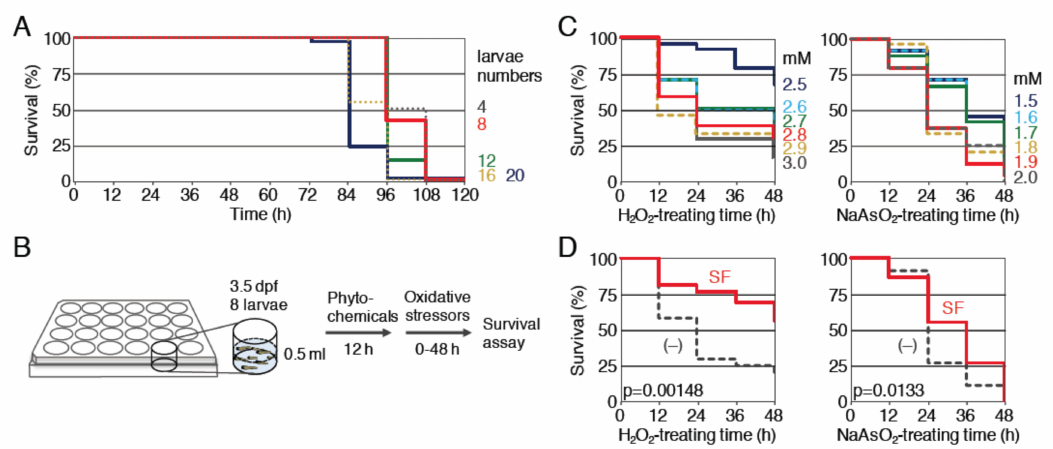
Figure 1. Survival assays of zebrafish larvae against oxidative stressors using 24-well plates. ( A ) Determination of the numbers of larvae. The indicated numbers of larvae (4 dpf) were placed into each well and survival rates were evaluated for 120 h without exchanging the medium. Larvae numbers: 4 (gray, dotted), 8 (red), 12 (green), 16 (yellow, dotted), 20 (purple). ( B ) A schematic diagram of the survival assay. Eight larvae (3.5 dpf) were placed into a single well of a 24-well plate, pretreated with phytochemicals for 12 h, then treated with oxidative stressors for 48 h, and the survival rates of the treated larvae were measured every 12 h. ( C ) Determination of the optimal concentration of oxidative stressors for the survival analysis. Larvae (4 dpf) were exposed to H 2 O 2 at concentrations of 2.5 to 3.0 mM ( left panel ; 2.5 (dark blue), 2.6 (light blue, dotted), 2.7 (green), 2.8 (red), 2.9 (yellow, dotted), 3.0 mM (gray)) or NaAsO 2 at concentrations of 1.5 to 2.0 mM ( right panel ; 1.5 (dark blue), 1.6 (light blue, dotted), 1.7 (green), 1.8 (yellow, dotted), 1.9 (red), 2.0 mM (gray, dotted)) for 48 h. Each analysis